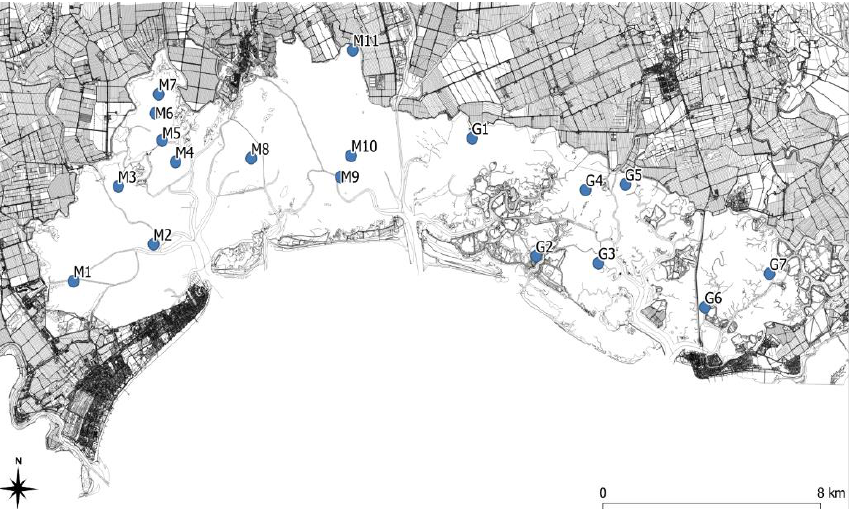
Figure 3. Monitoring sites in the Marano and Grado Lagoon (from M1 to M11 Marano basin, and from G1 to G7 Grado